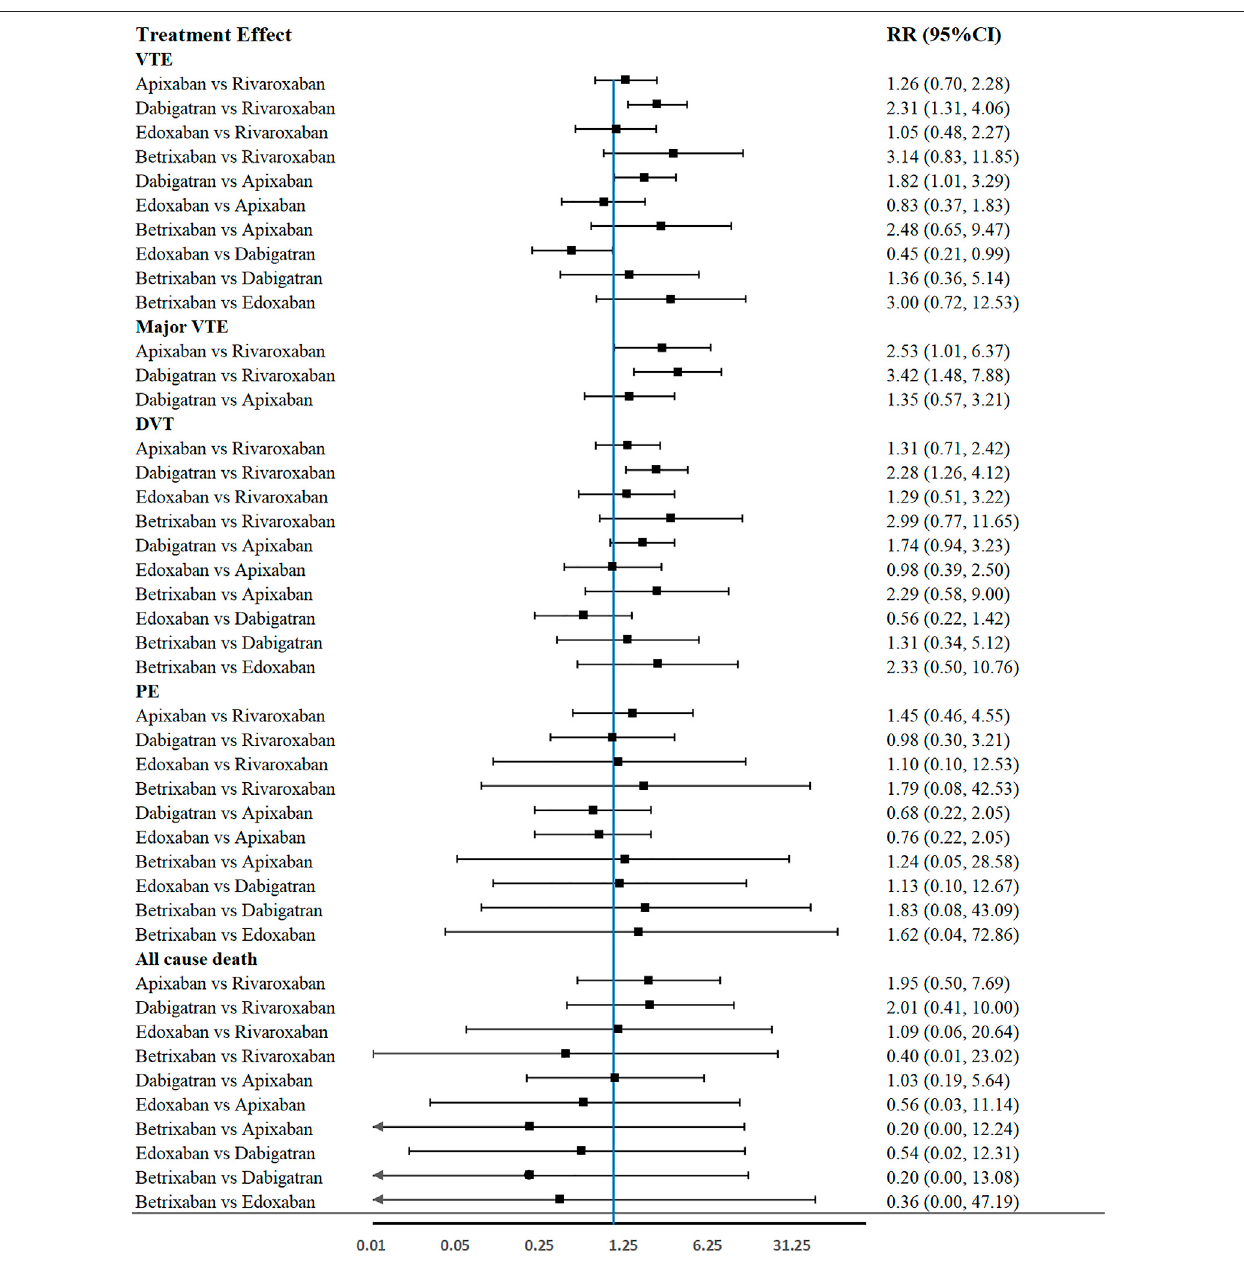
FIGURE 4 | Forest plot of network meta-analysis of different NOACs for VTE, major VTE, DVT, PE, and all causes of death in THA and TKA patients.